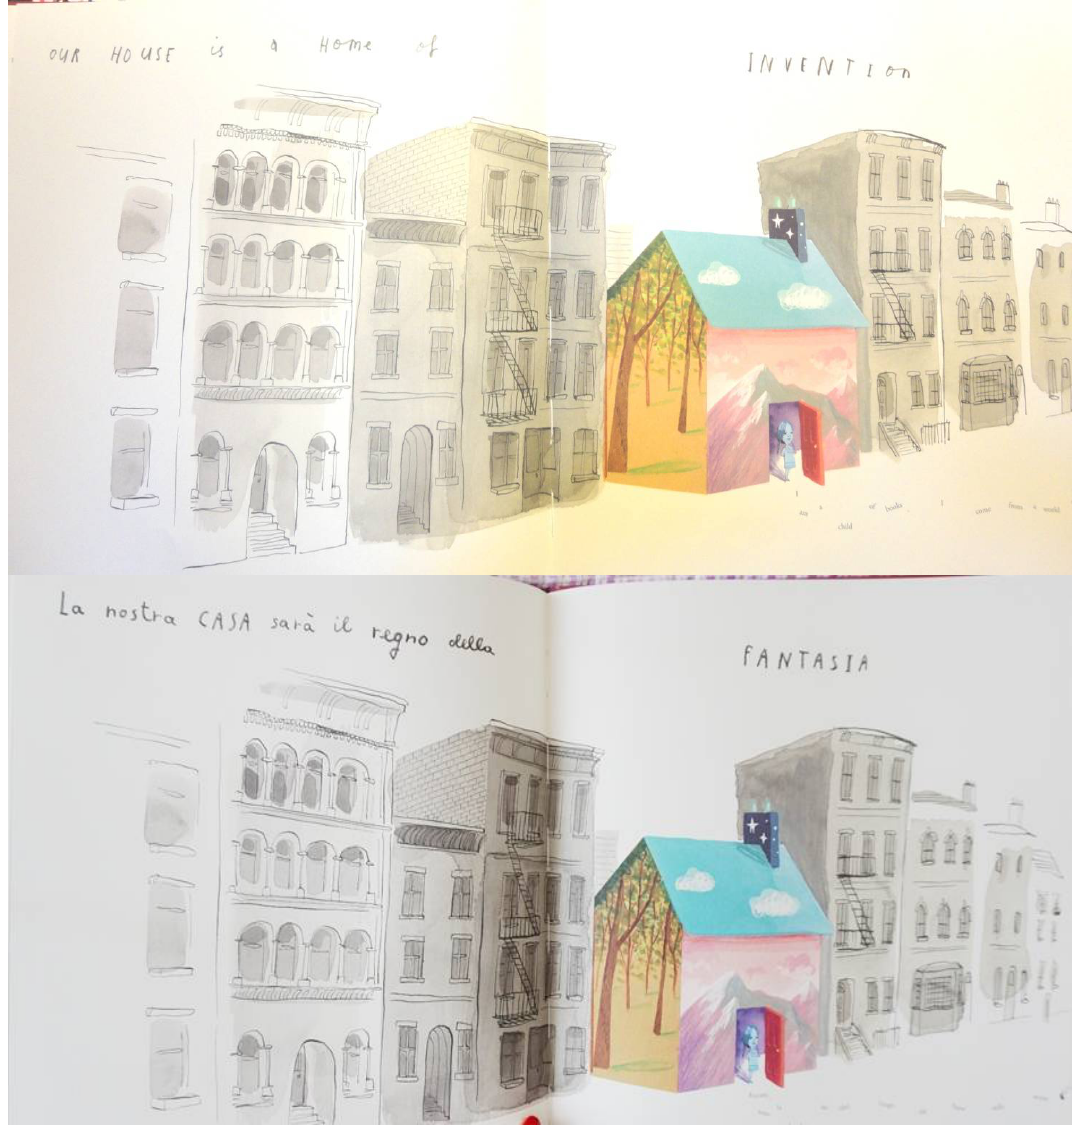
Figure A20. Jeffers O.; Winston S. A child of books, Walker Books, London, 2016; Jeffers O.; Winston S. La bambina dei libri, Lapis, Roma,